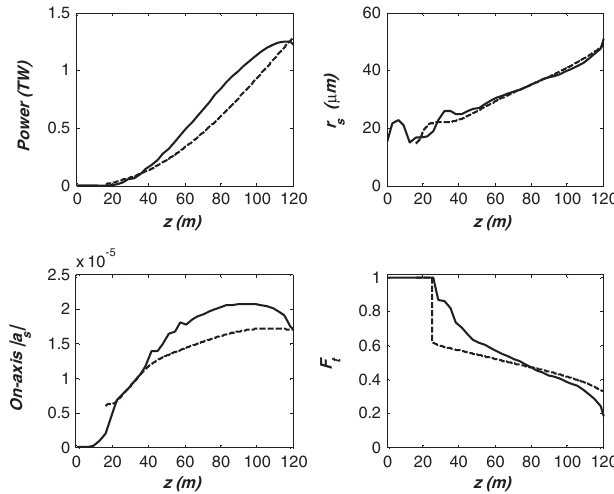
FIG. 2. Evolution with z of the radiation power within r ¼ j (obtained by fitting a Gaussian to , radius r and on-axis j a 3 r b 0 s s the radiation field data), and radially averaged trapping fraction F for Case A, obtained by GENESIS single-frequency simulation t (solid lines) and the physical model (dashed lines).